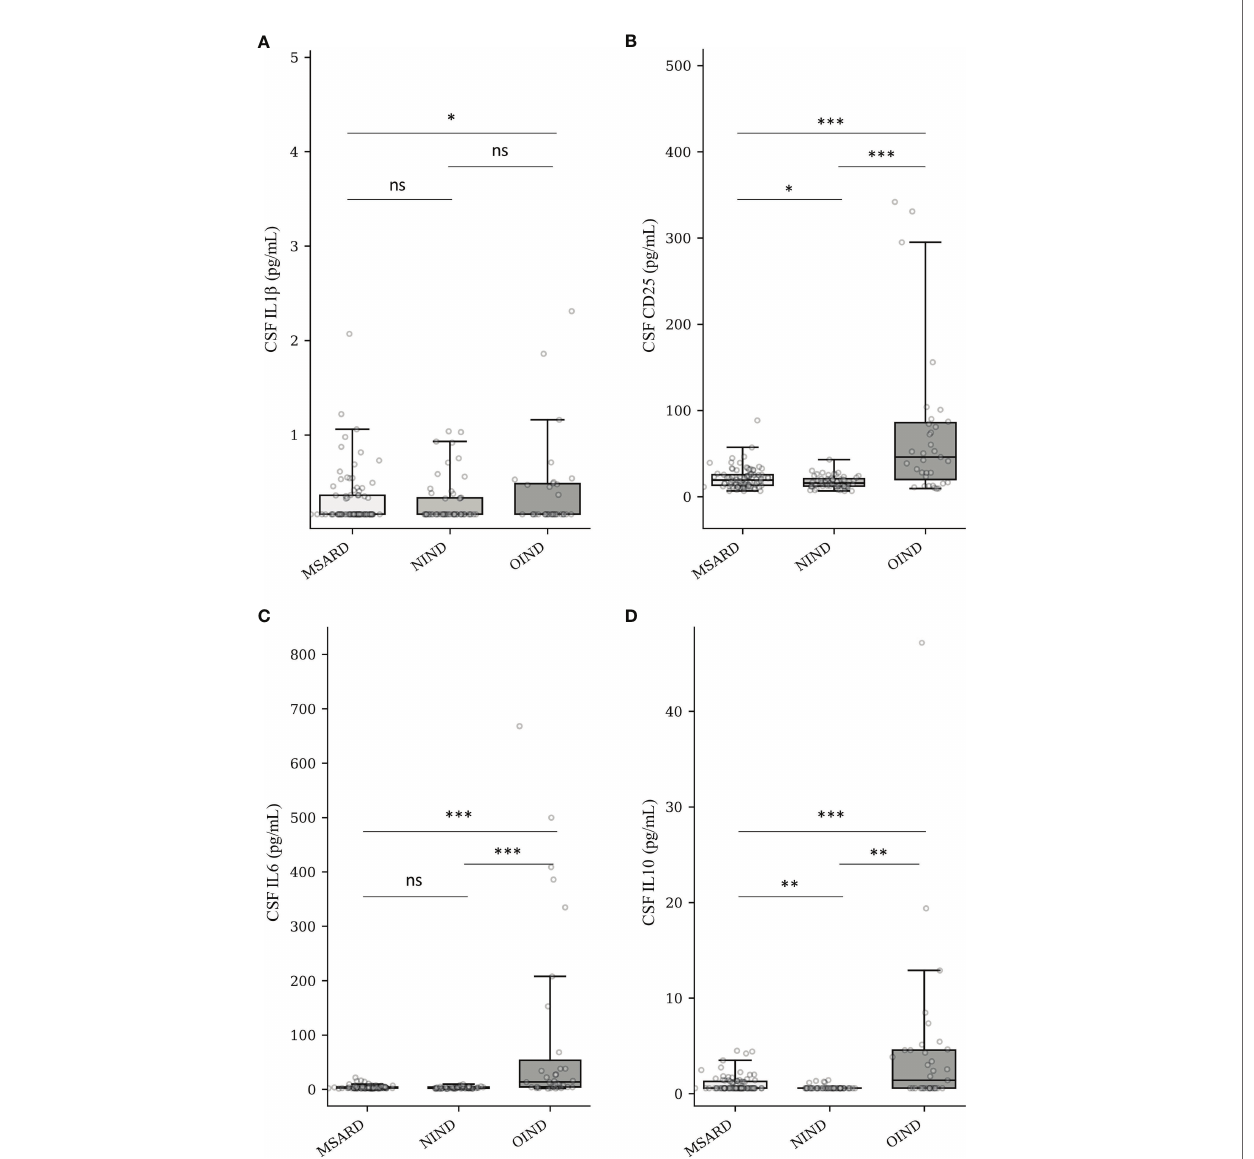
FIGURE 2 | Quanti fi cation of CSF IL-1 b (A) , CD25 (sIL-2R) (B) , IL-6 (C) , and IL-10 (D) into groups. MSARD, multiple sclerosis and related disorders ( n = 88); NIND, non-in fl ammatory neurological disorders ( n = 53); OIND, other in fl ammatory neurological disorders ( n = 35); ns, non-signi fi cant ( p > 0.05). * p < 0.05. ** p < 0.01. *** p < 0.001. CSF, cerebrospinal fl